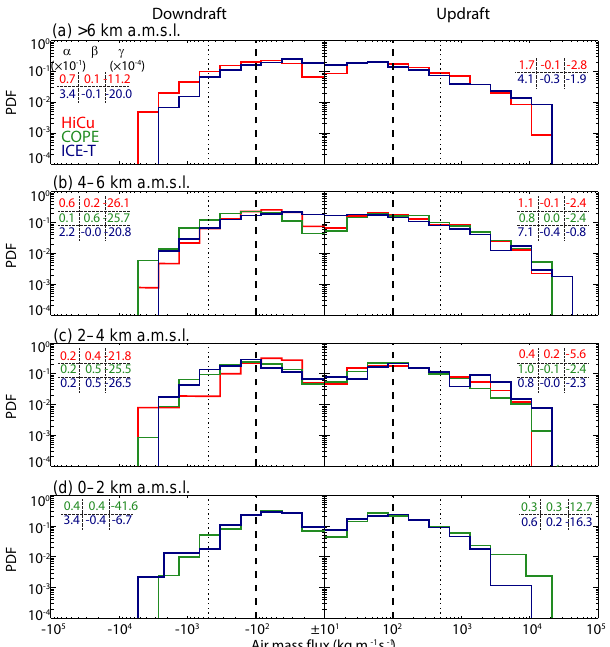
Figure 9. PDFs of the air mass flux for the updrafts and downdrafts sampled at 0–2, 2–4, and 4–6km and higher than 6km. The three thresholds of the air mass flux ( ± 10, ± 100, and ± 500kgm − 1 s − 1 ) are shown by the solid (overlaps with the central y axis in each panel), dashed, and dotted lines. The numbers shown in each panel are the coefficients of the fitted exponential function (Eq. 1).